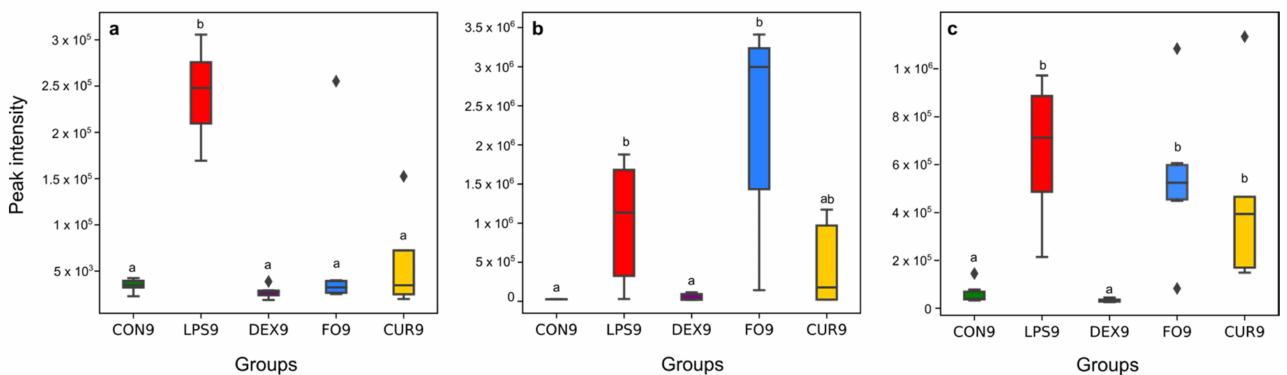
Figure 5. Effect of LPS, DEX, FO, and CUR on selected biomarkers, highly representative for the carboxylic acid derivatives subclass (( a ), ID23), fatty amides subclass (( b ), ID17), and steroid hormone biosynthesis and metabolism (( c ), ID31). The different letters indicate a significant difference between groups ( p -value <